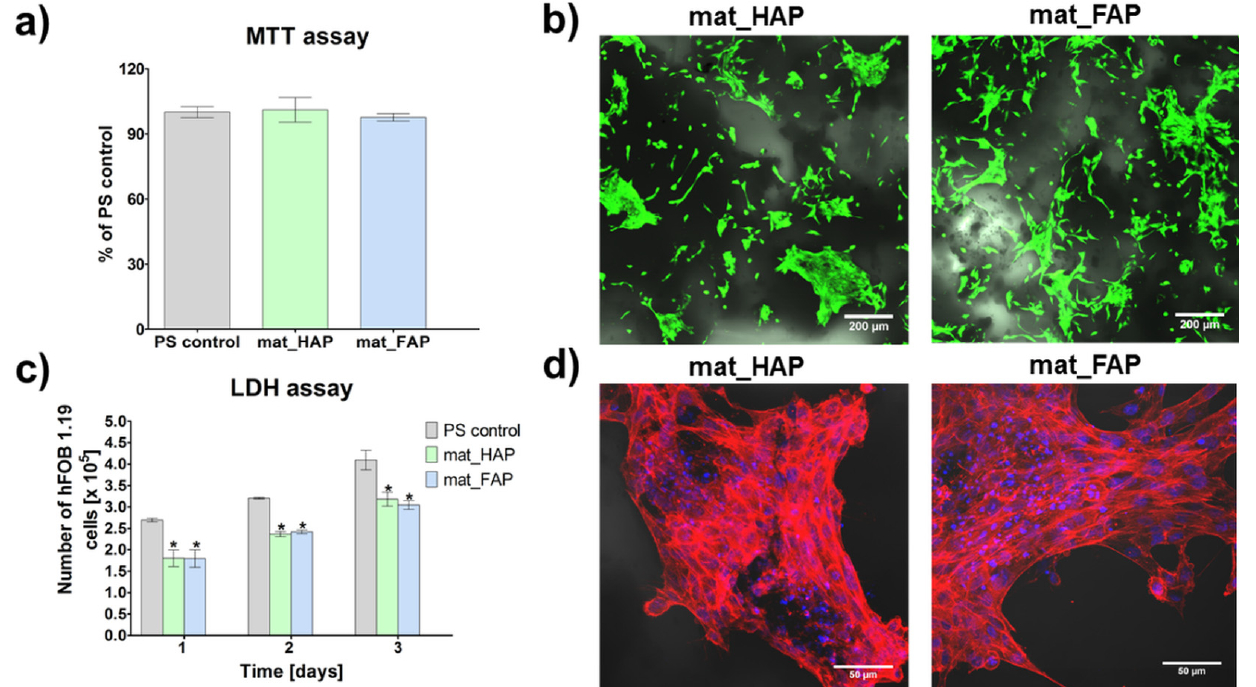
Figure 4. Biocompatibility assays with the use of normal human foetal osteoblast cell line (hFOB 1.19): ( a ) cytotoxicity assessment according to ISO10993-5 procedure by MTT assay, conducted with the use of 24 h biomaterial extracts (PS control—control cells exposed to culture medium incubated without biomaterial, in polystyrene wells, served as negative control of cytotoxicity); ( b ) confocal laser scanning microscope images, presenting live/dead staining of cells cultured on the surface of the biomaterials for 48 h (green fl uorescence—live cells, red fl uorescence—dead cells, Nomarski contrast was applied to visualize biomaterials, magni fi cation 100×; scale bar = 200 µm); ( c ) cell proliferation assessment by total LDH assay (PS control—cells cultured in the polystyrene wells; * statistically signi fi cant results compared to PS control, p < 0.05, one-way ANOVA followed by Tukey’s test); ( d ) confocal laser scanning microscope images, presenting fl uorescent staining of the cell cytoskeleton after 3-day cell culture on the surface of biomaterials (red fl uorescence—actin fi lament, blue fl uorescence—nuclei, magni fi cation 200×; scale bar = 50 µm).